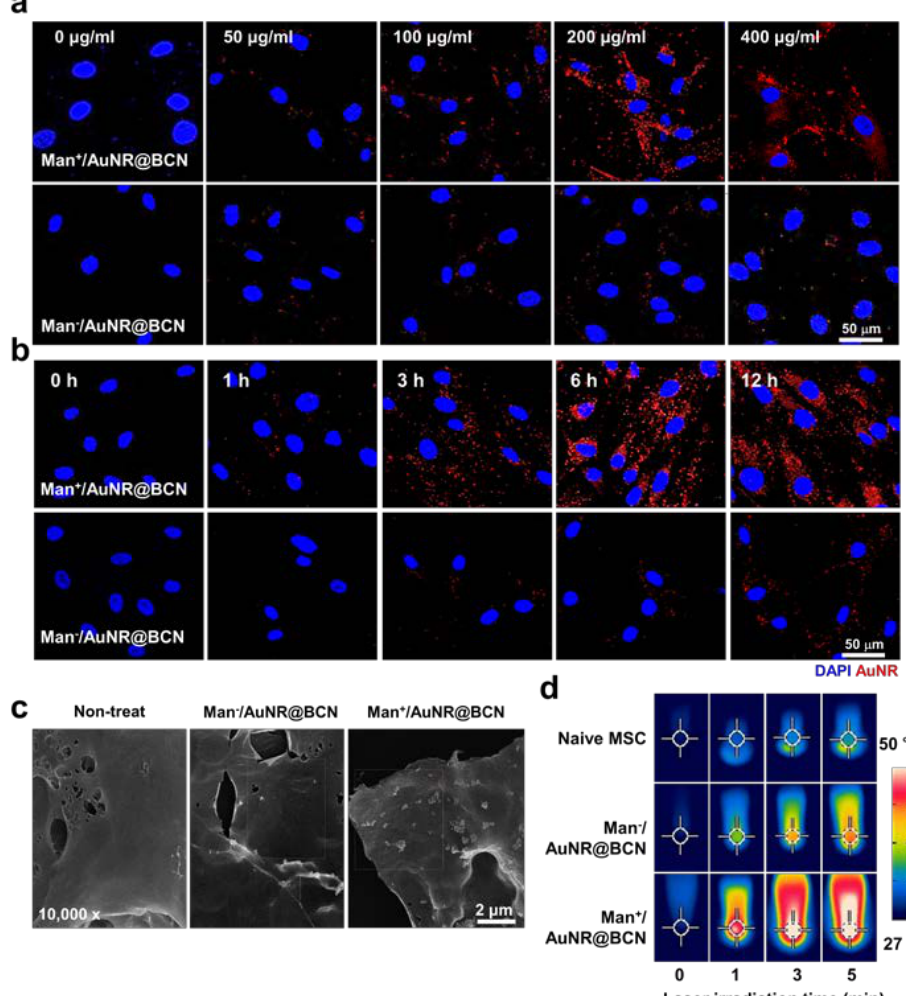
Figure 3. Preparation of AuNR-incorporated MSCs (AuNR@MSCs) in stem cell cultured system. ( a ) Fluorescence images of Ac 4 ManNAz-treated or naive MSCs after incubation with different concentrations of Cy5.5-AuNR@BCN. ( b ) Fluorescence images of Ac 4 ManNAz-treated or naive MSCs after incubation with 200 μg/mL of Cy5.5-AuNR@BCN for 0, 1, 3, 6, or 12 h. ( c ) Optical images of Ac 4 ManNAz-treated or naive MSCs after incubation with 200 µ g/mL of Cy5.5-AuNR@BCN for 6